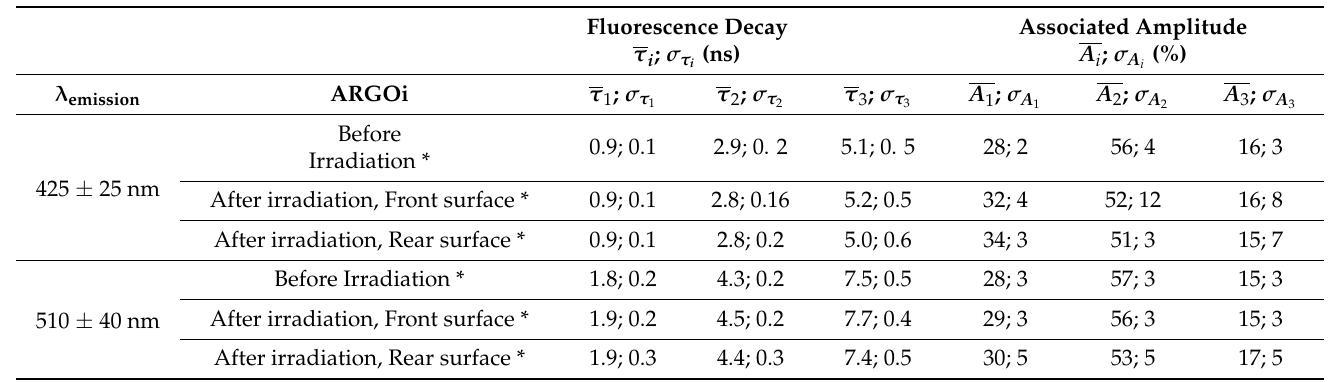
Table 4. Fitting parameters with a three exponential decay time model for all DLW